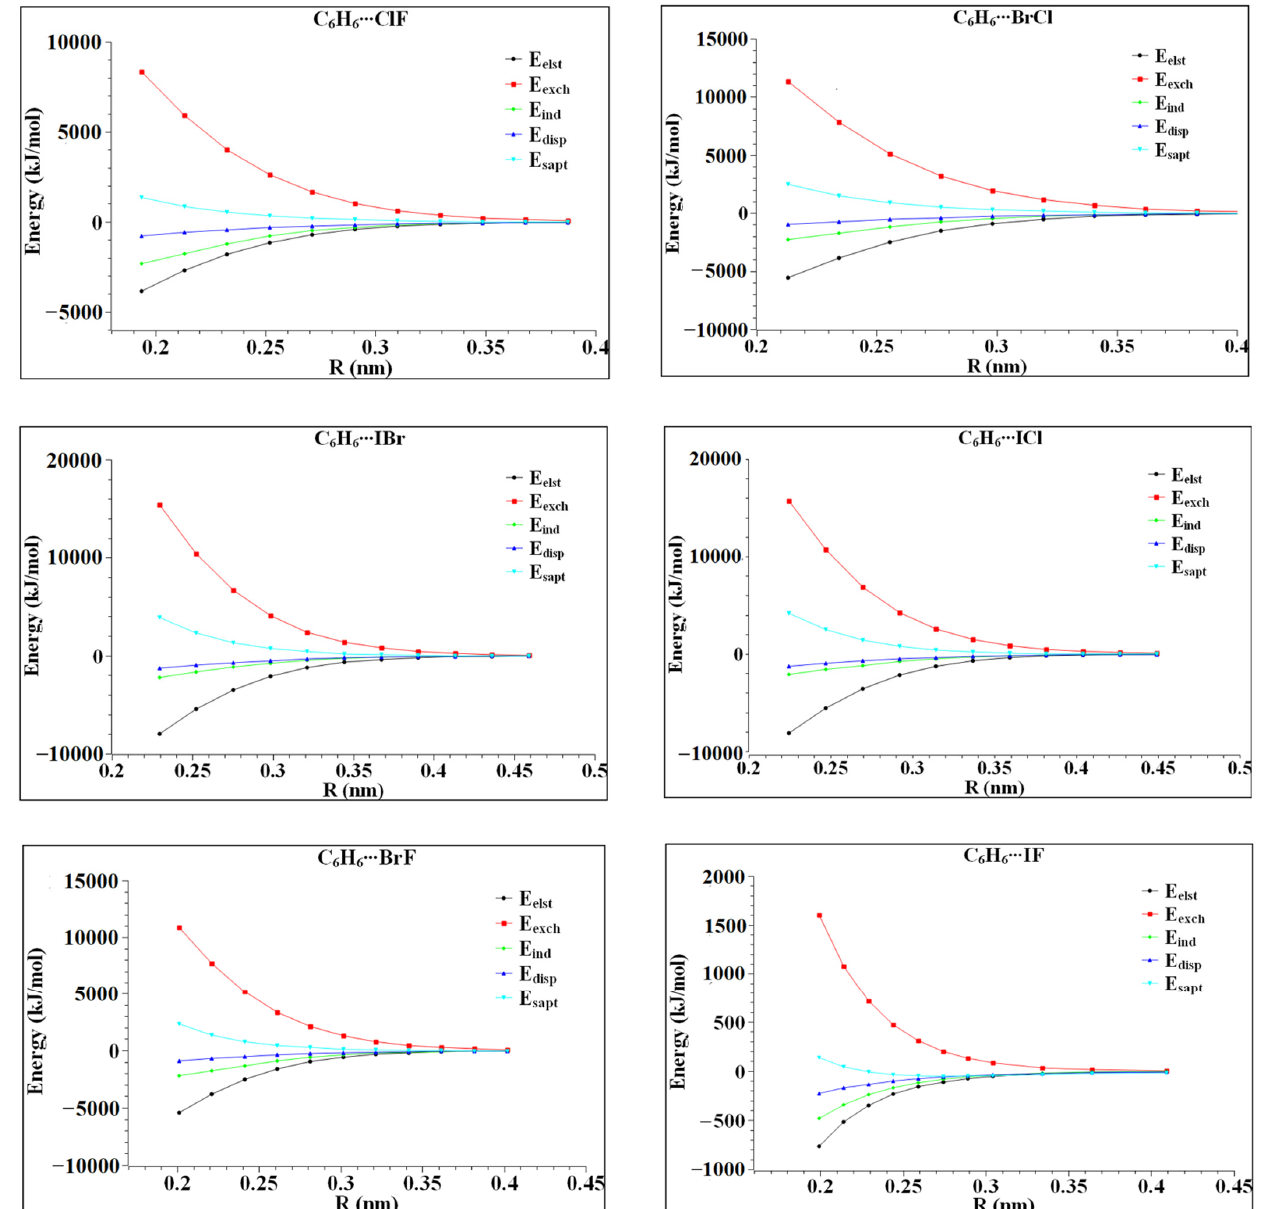
Figure 6. The interaction energy varies with the distance from the centroid of heteronuclear halogen